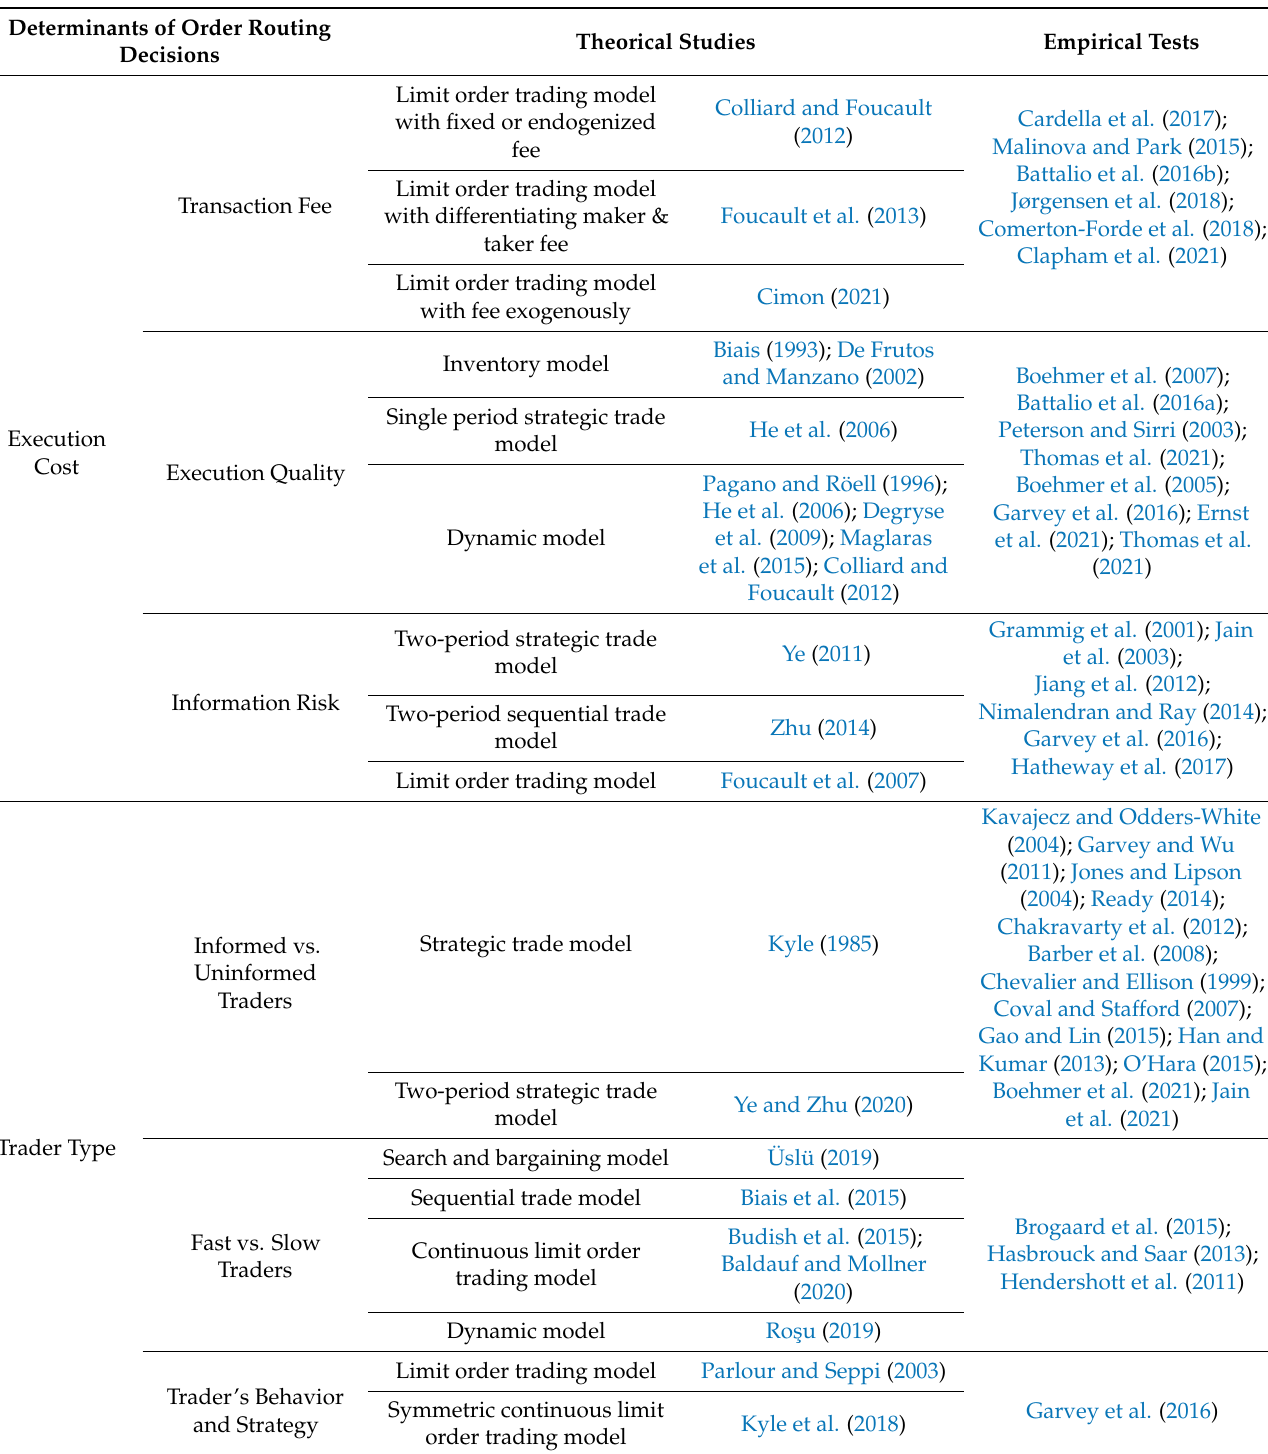
Table 3. Overview of studies on potential determinants of order routing